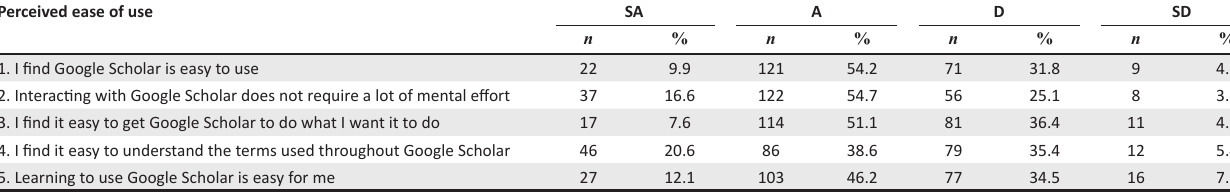
TABLE 3: Perception of postgraduate students on the ease of use of Google Scholar. Perceived ease of use